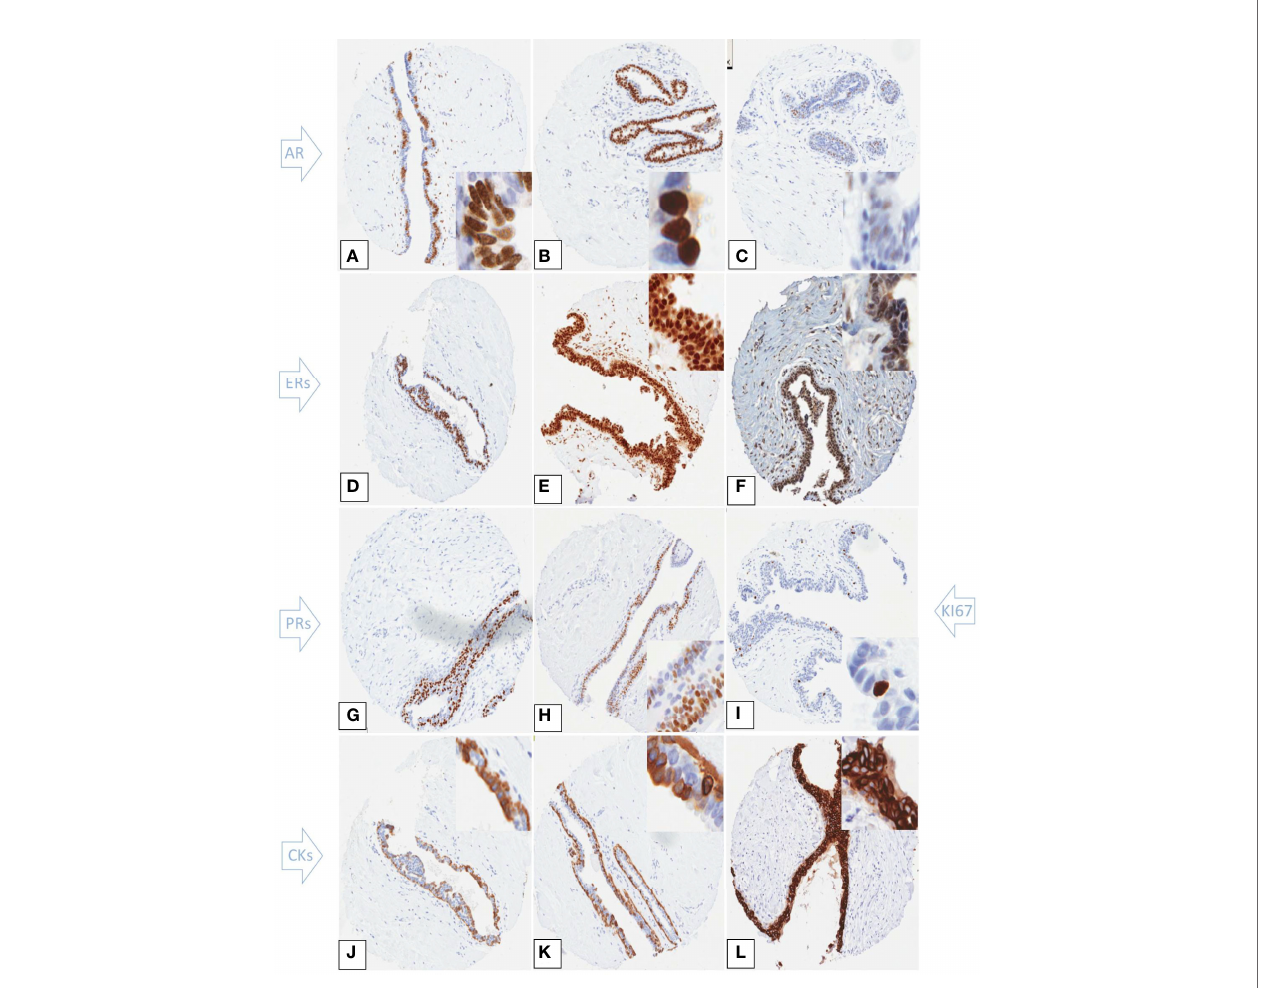
FIGURE 2 | Immunohistochemical expression of hormone receptors, Ki67 and cytokeratins in tissue microarray cores of gynaecomastia. Insets are higher power views of the cellular expression. (A – C) Androgen receptor staining showing strong patchy (A) and uniform (B) nuclear staining. (C) shows occasional AR weakly stained cells. (D) ER a strong nuclear staining in the majority of nuclei of the hyperplastic ducts. ER b 1 (E) and ER b 2 (F) showed strong nuclear expression within both the epithelial and stromal cells. Total PR (G) and PR a (H) exhibited strong nuclear staining in most of epithelial cell nuclei. The Ki67 proliferation index was low within the hyperplasic ducts (I) . CK5/6 (J) and CK14 (K) were positive within the mammary ducts that showed a tri-layered pattern of cytokeratin staining. The inner and outer layers were CK5/6 and CK14 positive while the middle layer was negative. CK8/18 showed strong and uniform membranous staining of the epithelial cells (L)